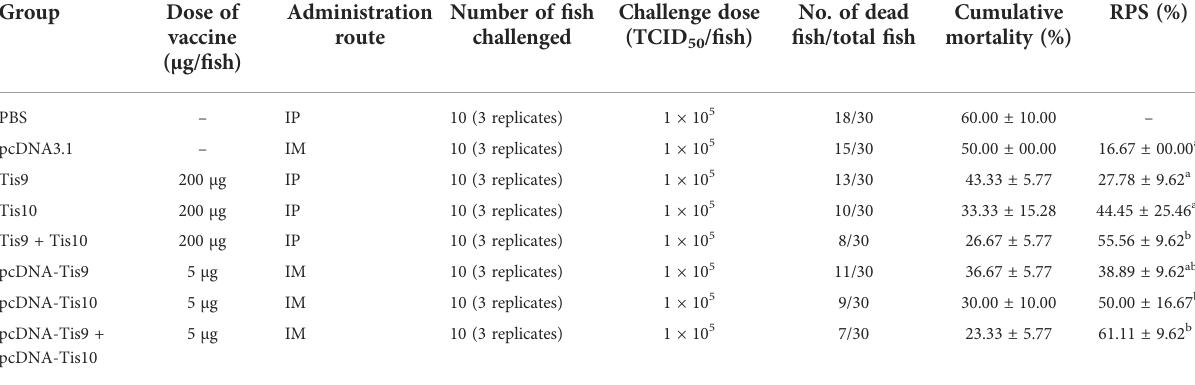
TABLE 3 Cumulative mortality and RPS values of vaccinated fi sh at 28 days post TiLV challenge. Group